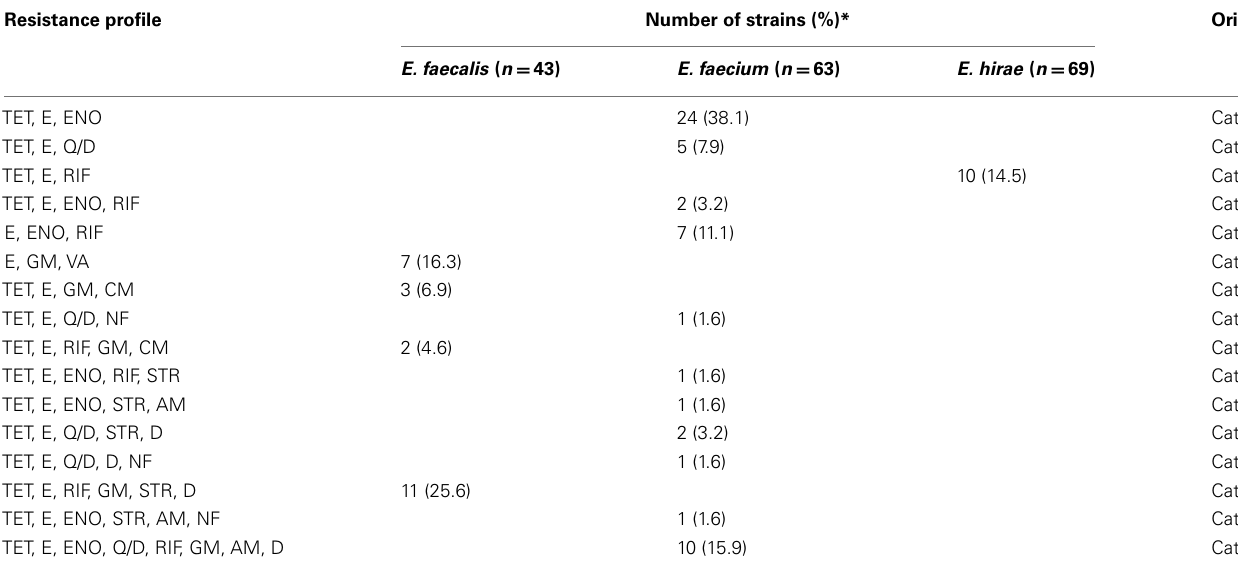
Table 2 | Multiple ( ≥ 3) antimicrobial resistance profile among enterococcal isolates from the feces of resident cats from small animal veterinary hospitals.